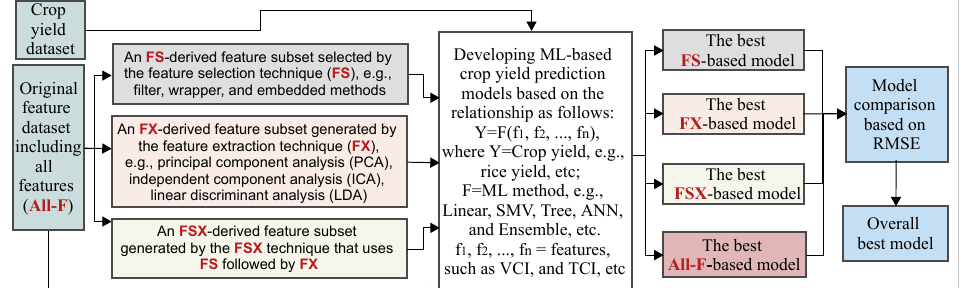
Figure 1. Flowchart illustrating the selection of the best performing ML-based crop yield prediction models based on FS, FX, FSX, and